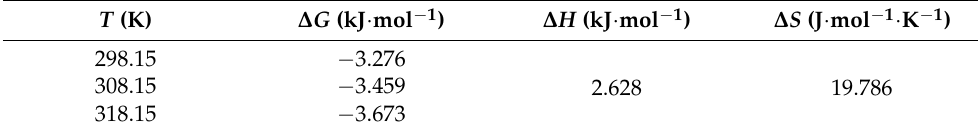
Table 3. Thermodynamic parameters for silicic acid adsorption on MIL-101(Fe).